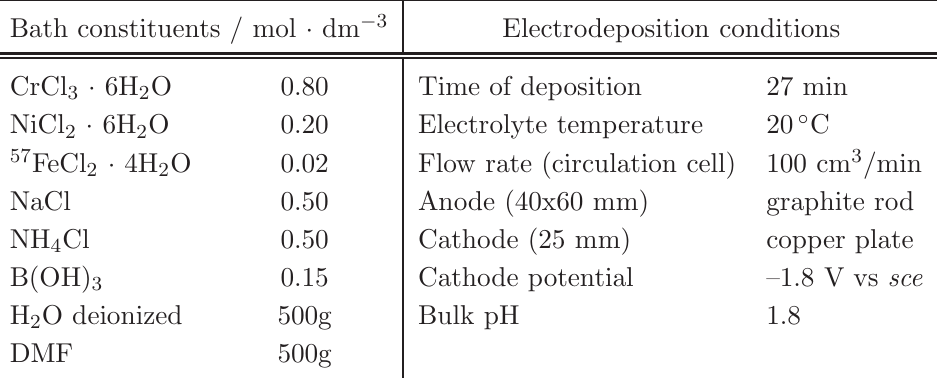
Table 1 Parameters of